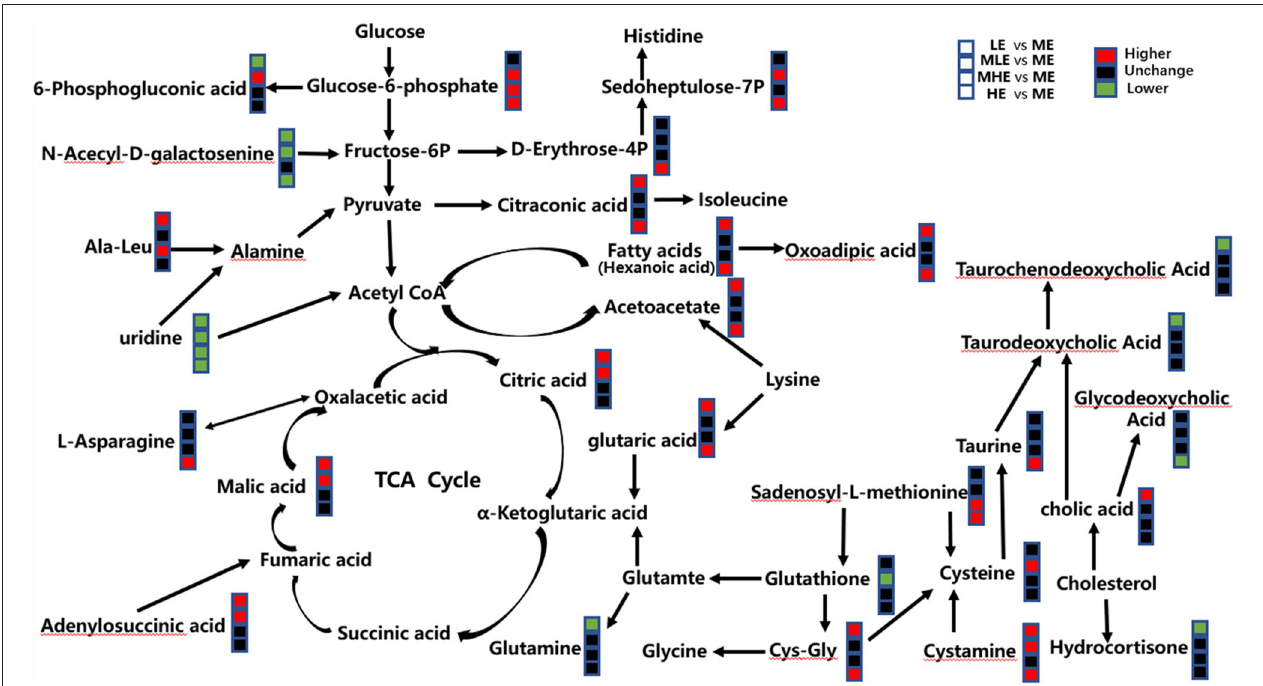
FIGURE 6 | Different metabolic pathways from the sheep of five groups. The red mark means that the concentration of the former group is higher than that of the latter group. The black mark means the difference is not significant, and the green mark means the concentration of the former group is lower than that of the latter group.